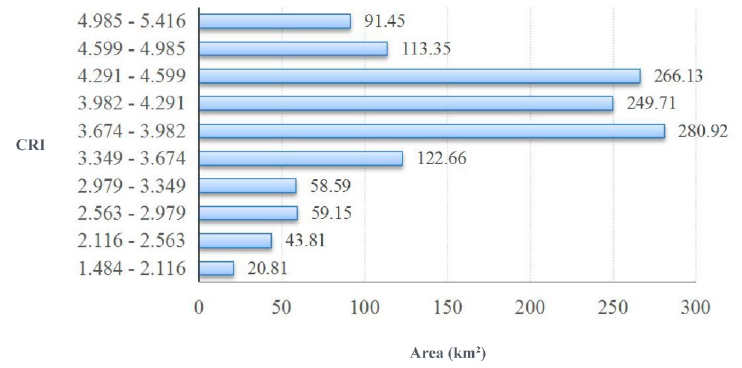
Figure 9. Area statistics of CRI class.